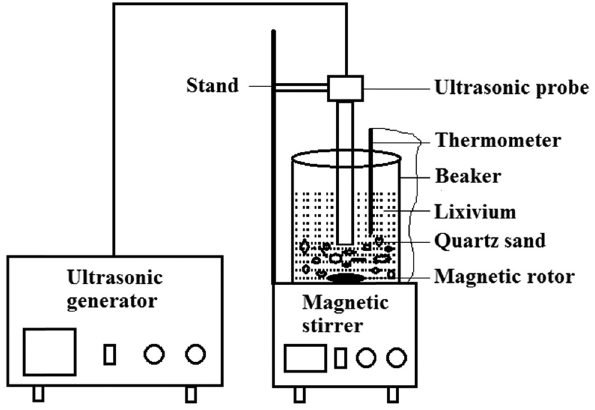
Figure 2: Schematic diagram of the experimental